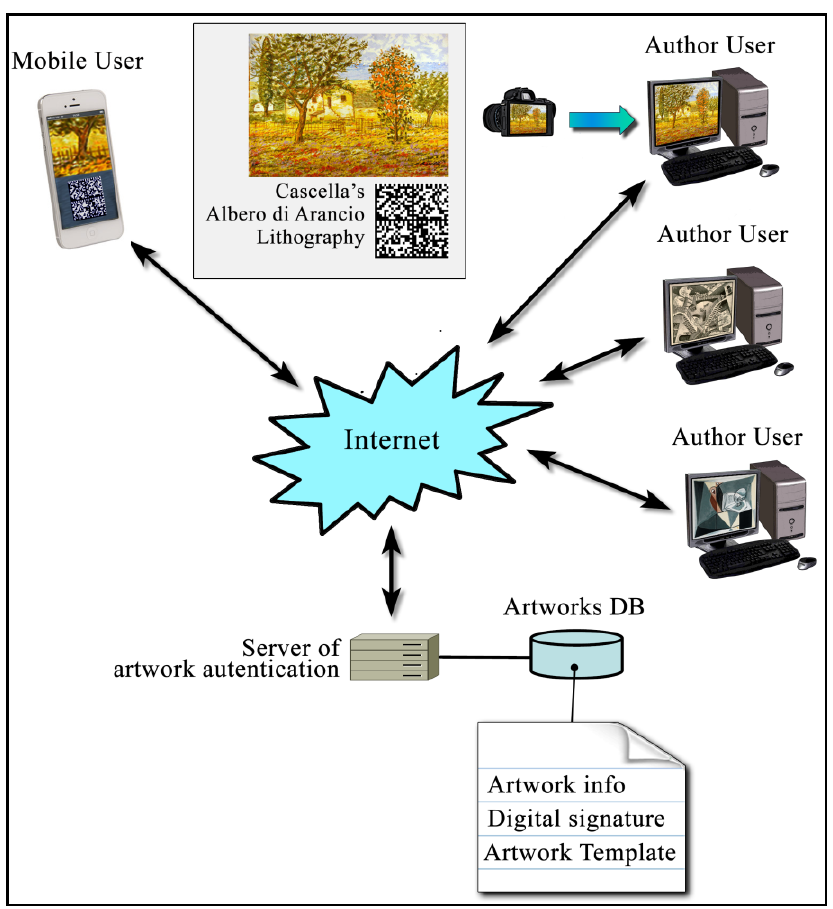
Figure 6. Schema showing the lithography authentication